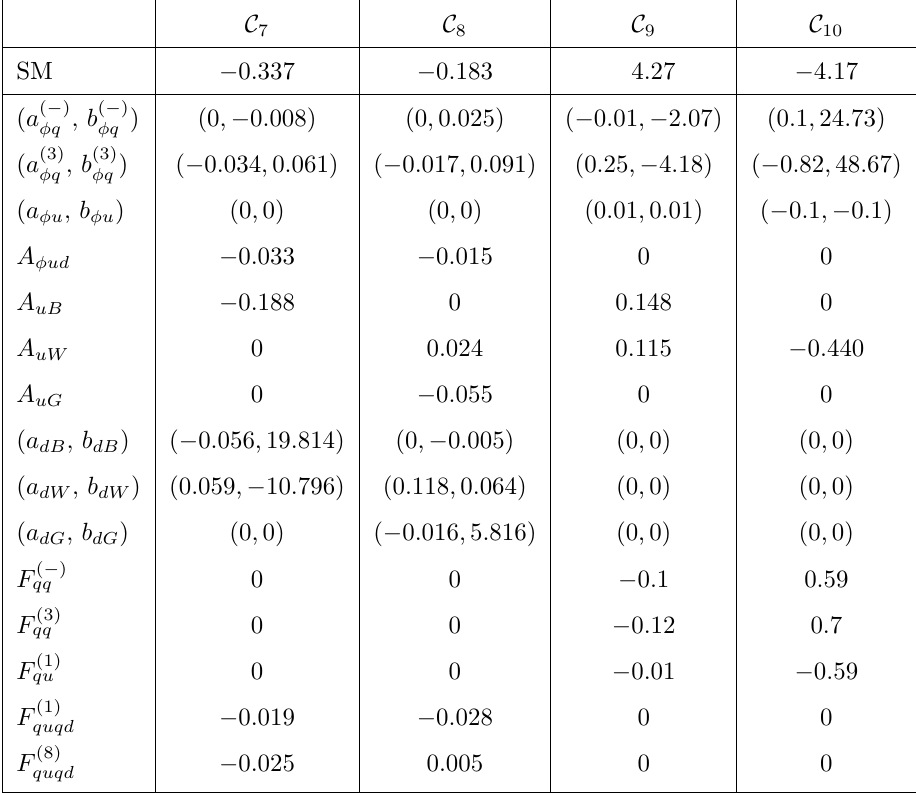
and C are not generated by 9 0 10 0